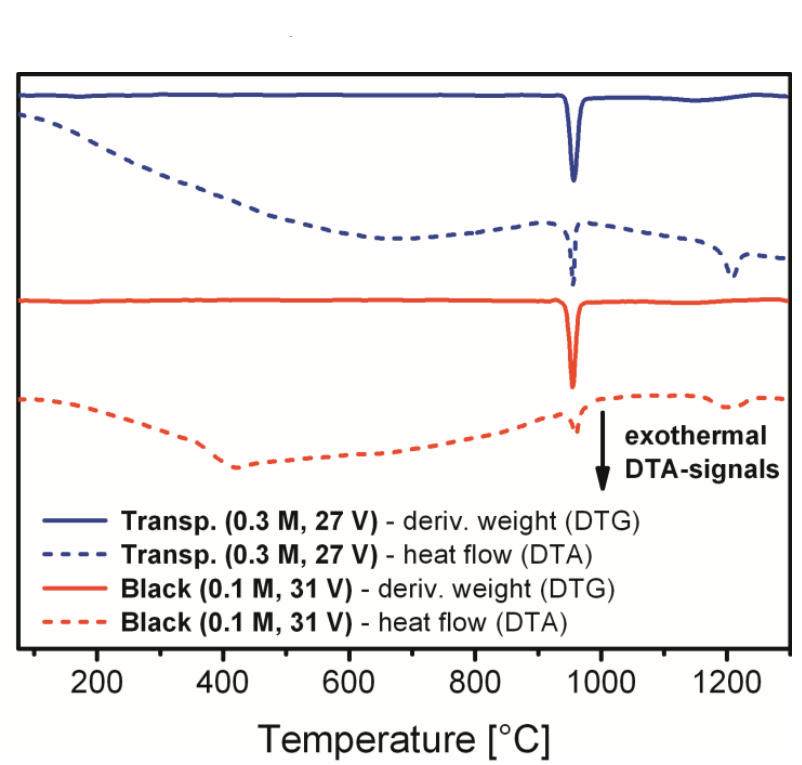
Figure 6. Comparison of DTG and DTA curves obtained for transparent PAA (shown in blue) and opaque black b-PAA samples (shown in red).